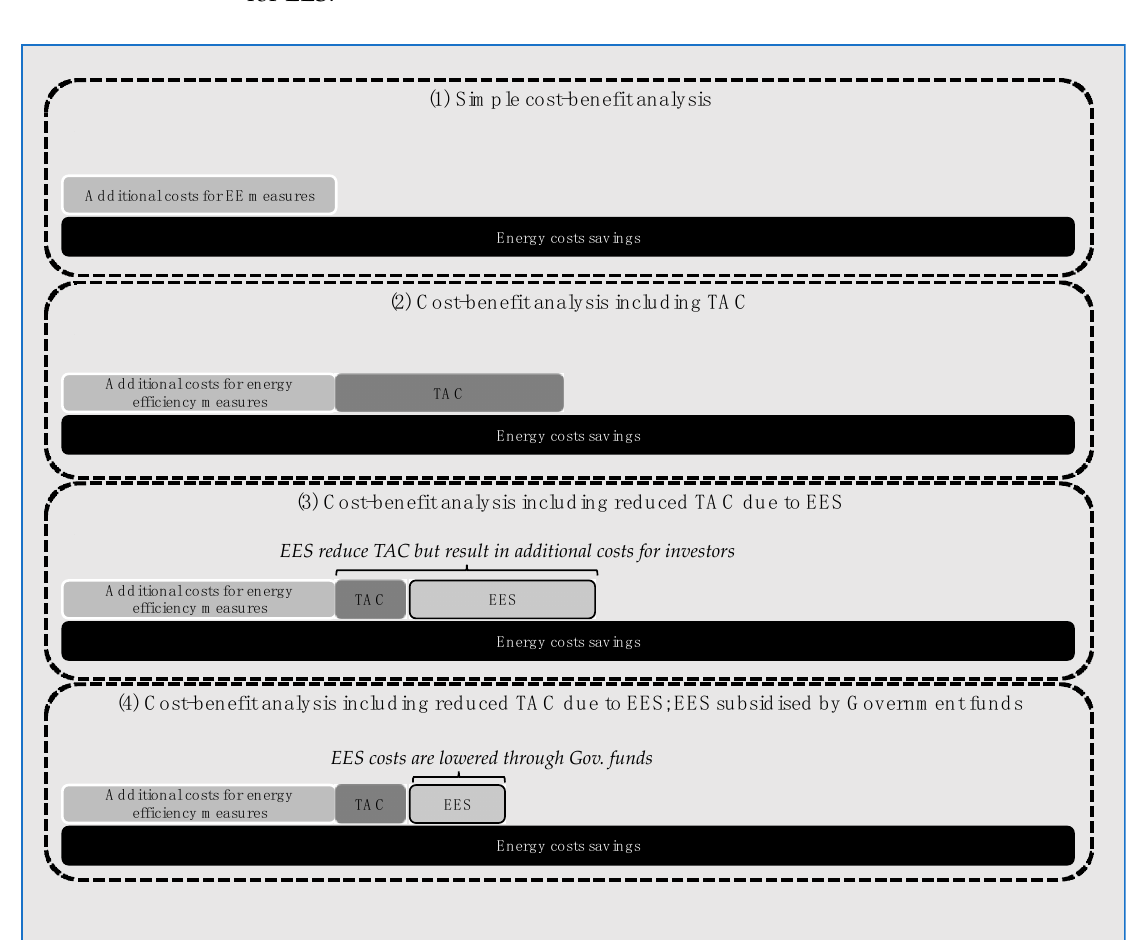
Figure 1. Schematic overview of a cost–benefit analysis (CBA) for the uptake of energy efficiency measures including transaction costs (TAC) and energy efficiency services (EES).